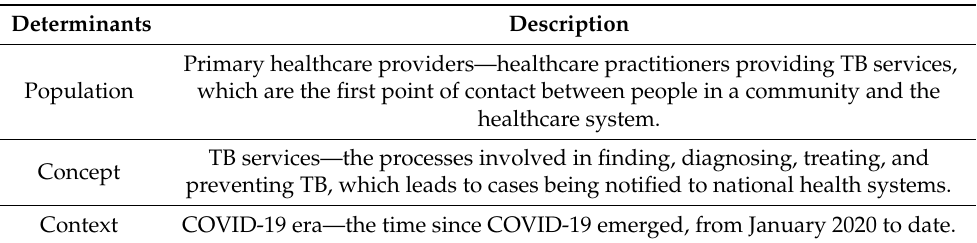
Table 1. PCC framework to determine the eligibility of the research question and guide the selection of studies on TB services during the COVID-19